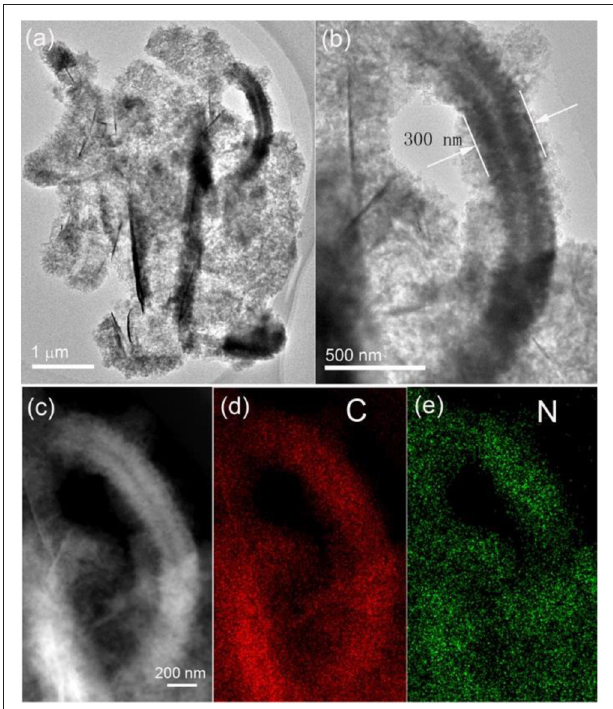
FIGURE 2 | Bright-field TEM images (a,b) , HADDF image (c) of the sandwich-structured hybrid material, and the element maps of C (d) , and N (e) corresponding to the figure shown in (c)